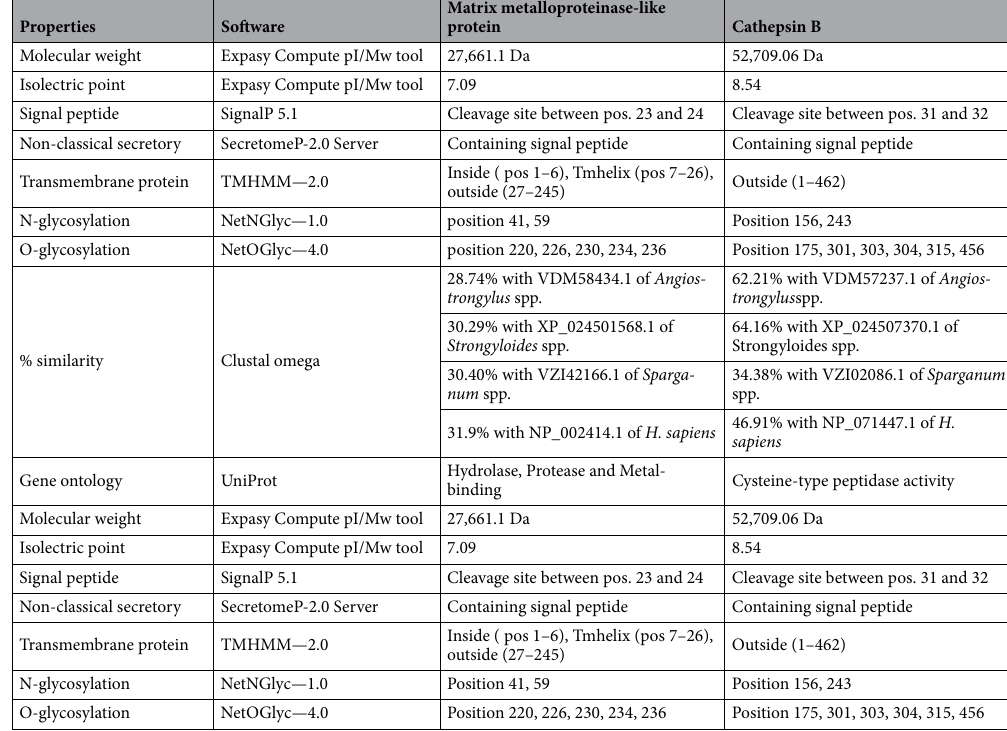
Table 6. The protein properties of G. spinigerum matrix metalloproteinase-like protein and cathepsin